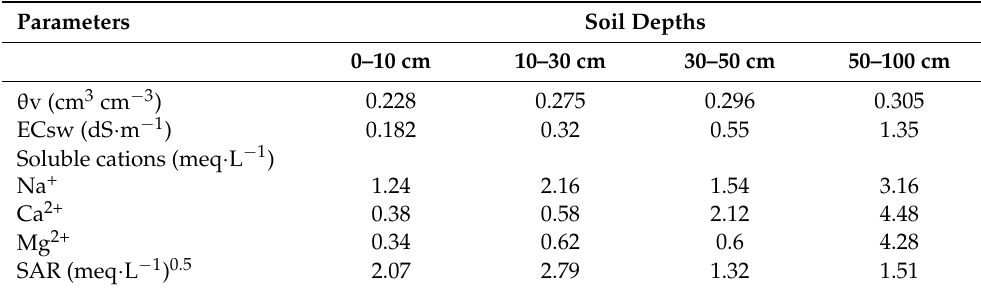
Table 4. The initial conditions of the soil profile of the monoliths